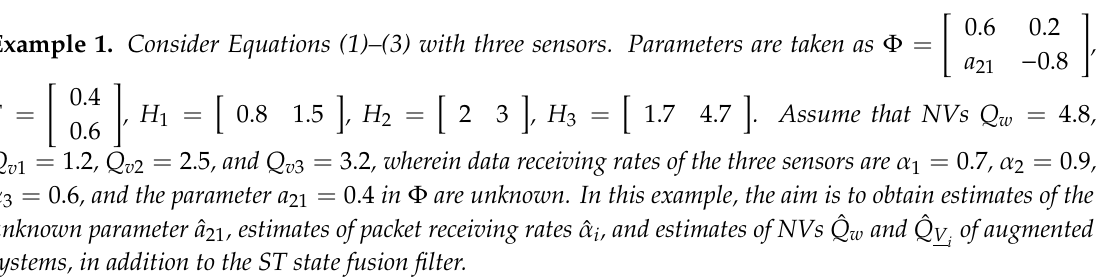
Figure 1. Identification of unknown packet receiving rates α i .